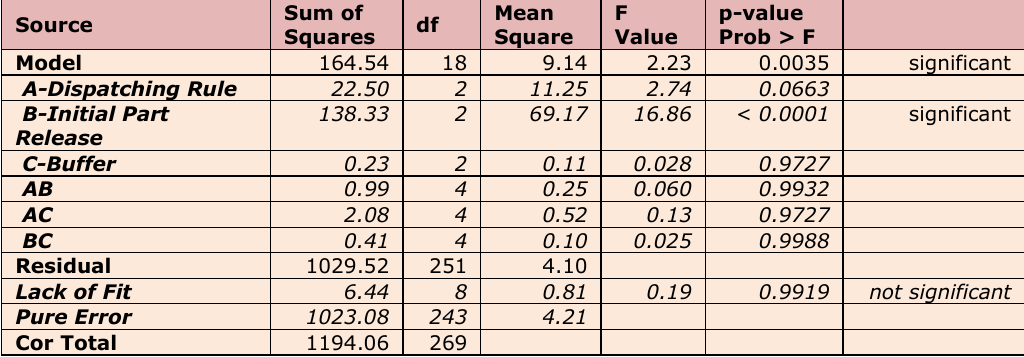
Table 10. ANOVA analysis for total run